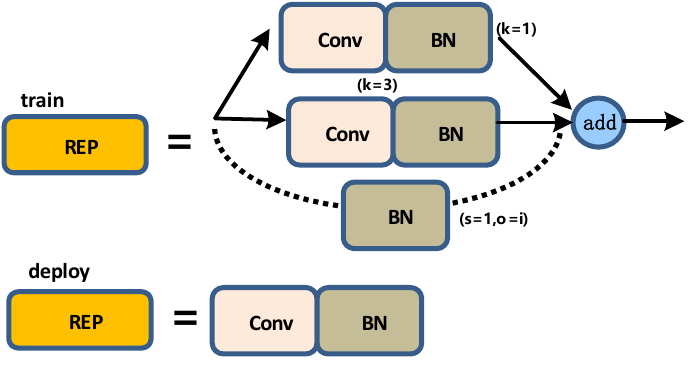
Figure 13. REP layer diagram.